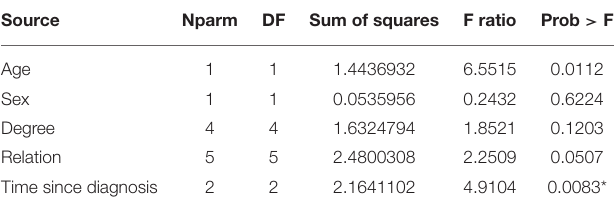
TABLE 3 | Distribution of background features for affiliate stigma.